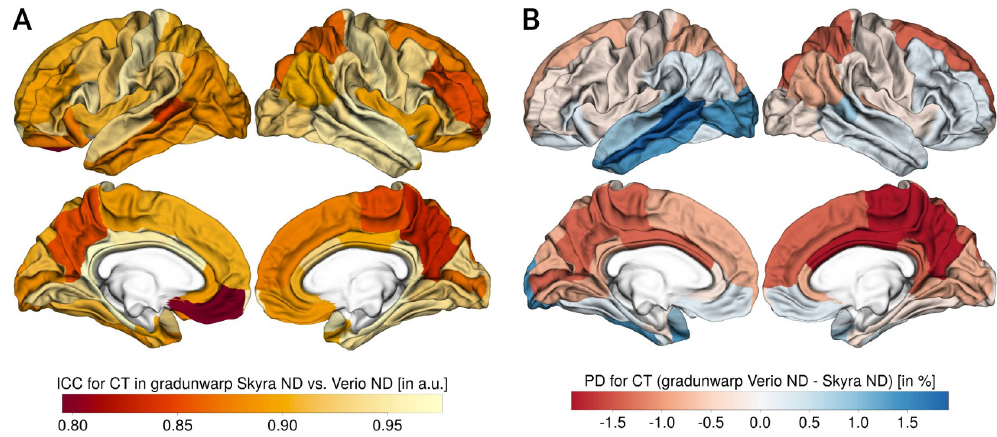
Fig 11. Comparison of cortical thickness (CT) results from gradunwarp-corrected data. Panel A: CT ICC, Panel B: CT PD (for each panel, left column shows lateral and medial view of left hemisphere, right column shows lateral and medial view of right hemisphere), negative values: Skyra > Verio, positive values: Verio > Skyra.